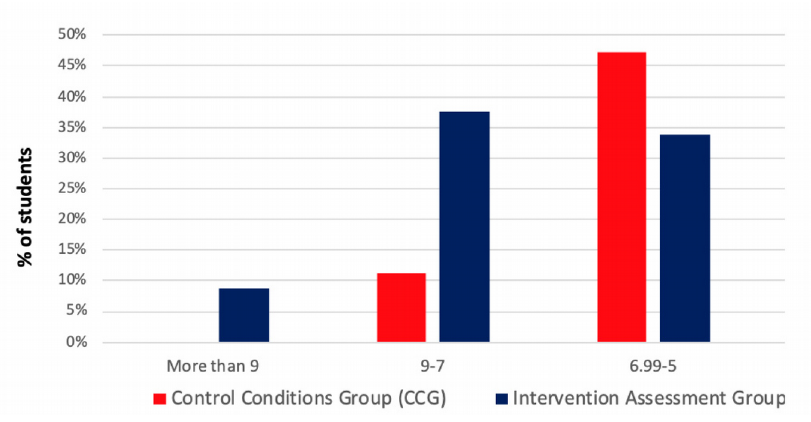
Figure 3. Distribution of the grades obtained by the students after completing the